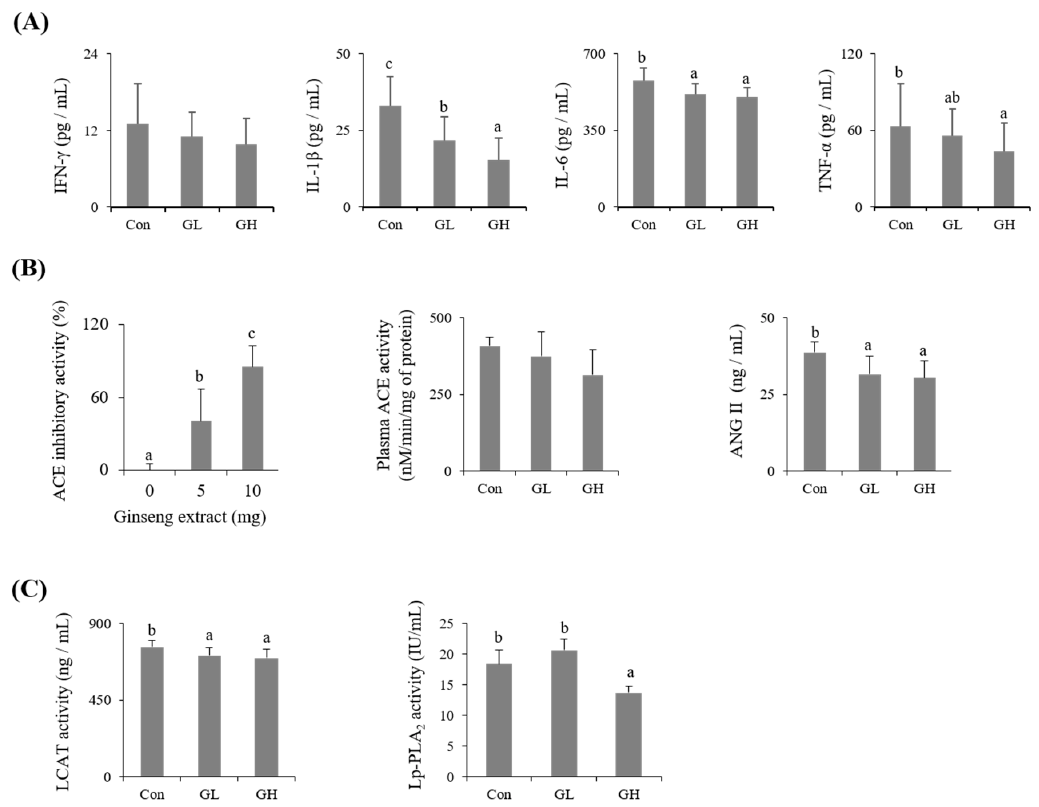
Figure 2. Effect of ginseng extract on production of plasma proinflammatory cytokines ( A ), blood pressure-related factors ( B ), and the plasma LPC-generating enzyme activities ( C ). Plasma Angiotensin (ANG) II, lipoprotein-associated phospholipase A 2 (Lp-PLA 2 ) and lecithin cholesterol acyltransferase (LCAT) were determined using enzyme-linked immunosorbent assay (ELISA) kits. Plasma inflammatory cytokines including IFN- γ , IL-1 β , IL-6, and TNF- α were measured using a luminex screen assay kit. Angiotensin-converting enzyme (ACE) inhibitory activity of ginseng and plasma ACE activity were measured at 228 nm by a spectrophotometer. Different letters on the bars indicate d significant differences at p < 0.05.